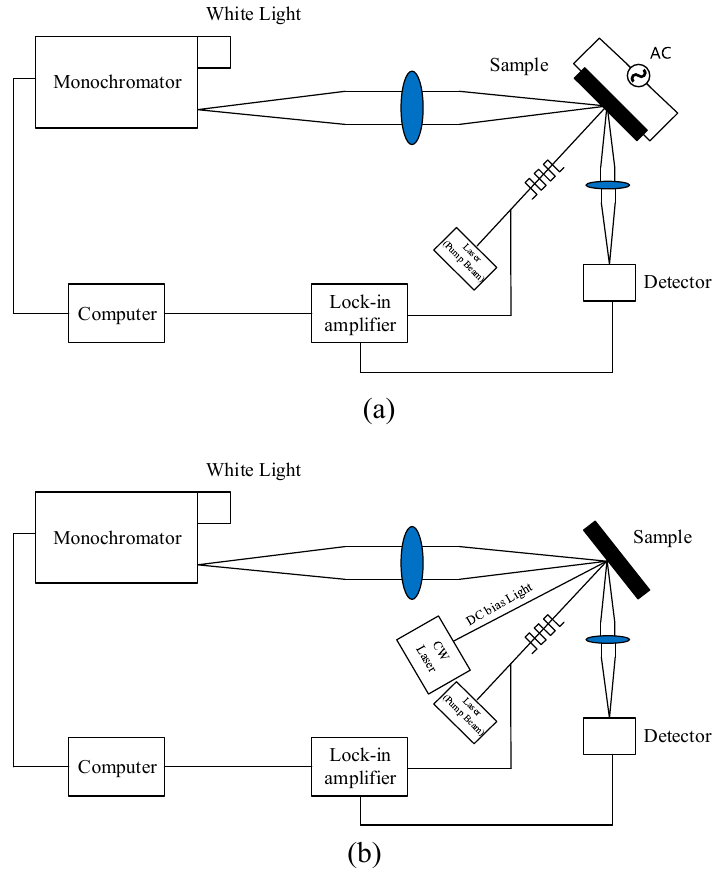
Figure 2. Schematic diagram of the experimental setup for ( a ) Electrically Biased Photoreflectance (EBPR) and ( b ) optically biased photoreflectance (OBPR) at room